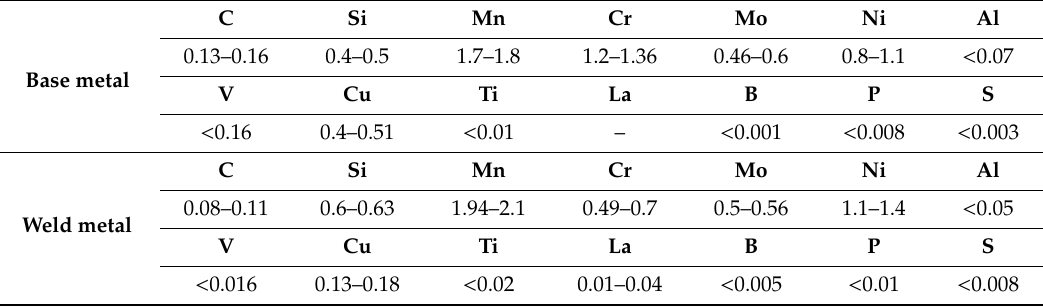
Table 5. Chemical composition of S960QL welds,